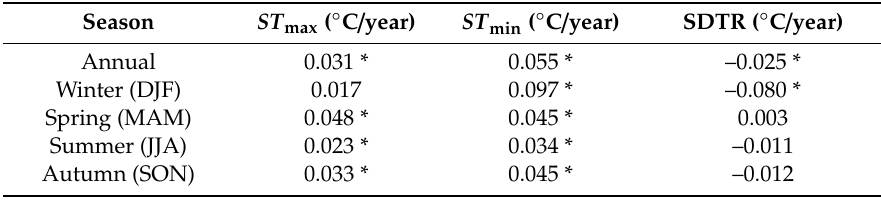
Table 2. National trends of ST max , ST min , and SDTR on annual and seasonal scales in China during 1962–2011.